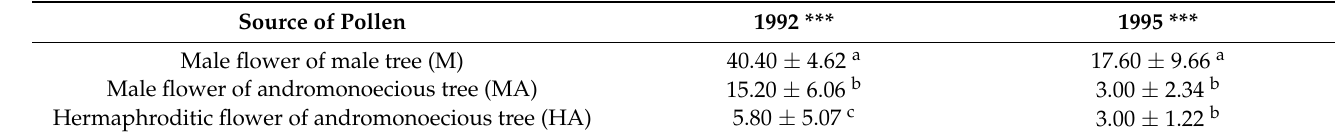
Table 1. Pollen germination rates.